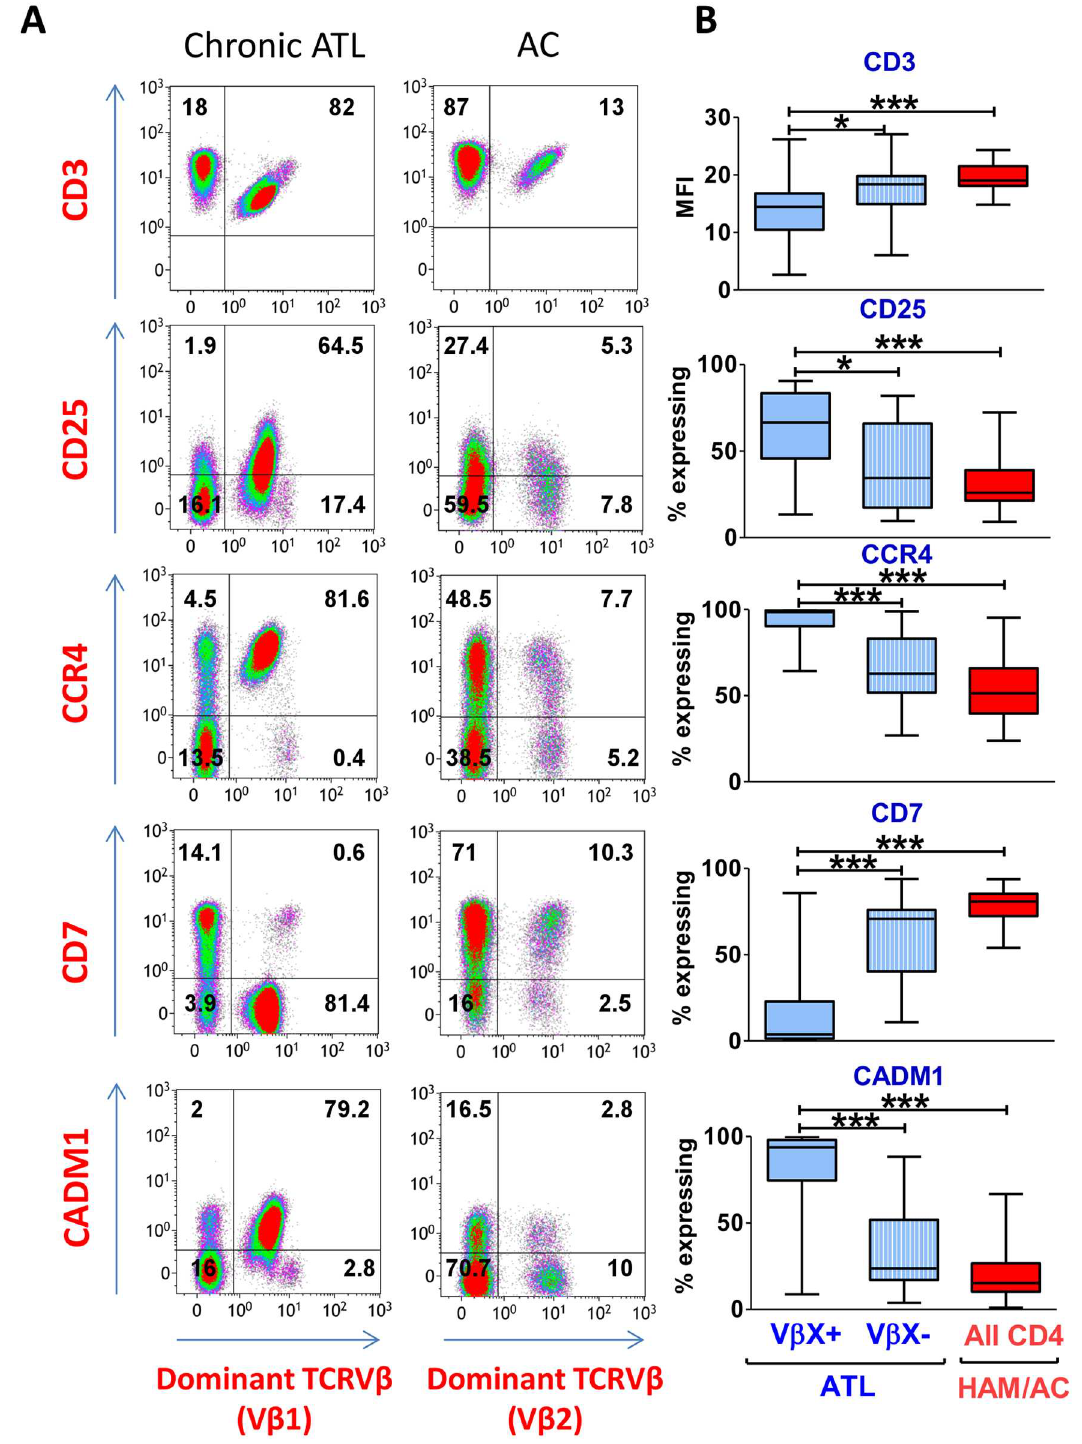
Fig 2. Expression of candidate ATL cell surface markers by the dominant TCRV β -expressing population. Staining was performed as describedin Fig 1. (A) Representative flow cytometry plots of total live CD3 + CD4 + cells from an ATL patient (LHN) and an AC (HHD). Plots display the most frequently expressedTCRV β subunit in the respectivedonor. (B) Expandedclones are CCR4 + CD7 − CADM1 + . Live CD3 + CD4 + T cells from ATL patients (n = 21) with an OCI-flow (CADM1 + CD3 + ) > 0.7 were gated on the basis of expressionof the dominant TCRV β (designatedTCRV β X + or TCRV β X –